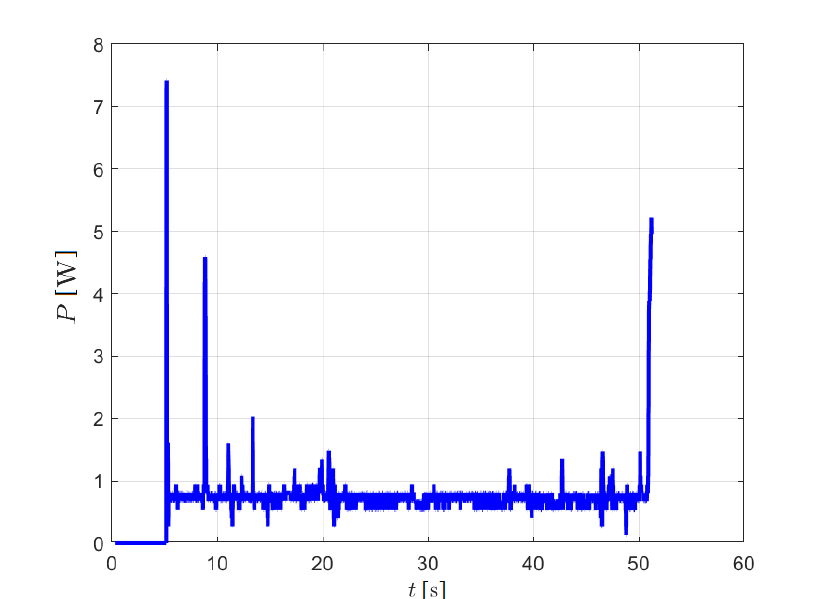
Figure 41. Power P during Map 2 run for the HybridA star algorithm of the robot.